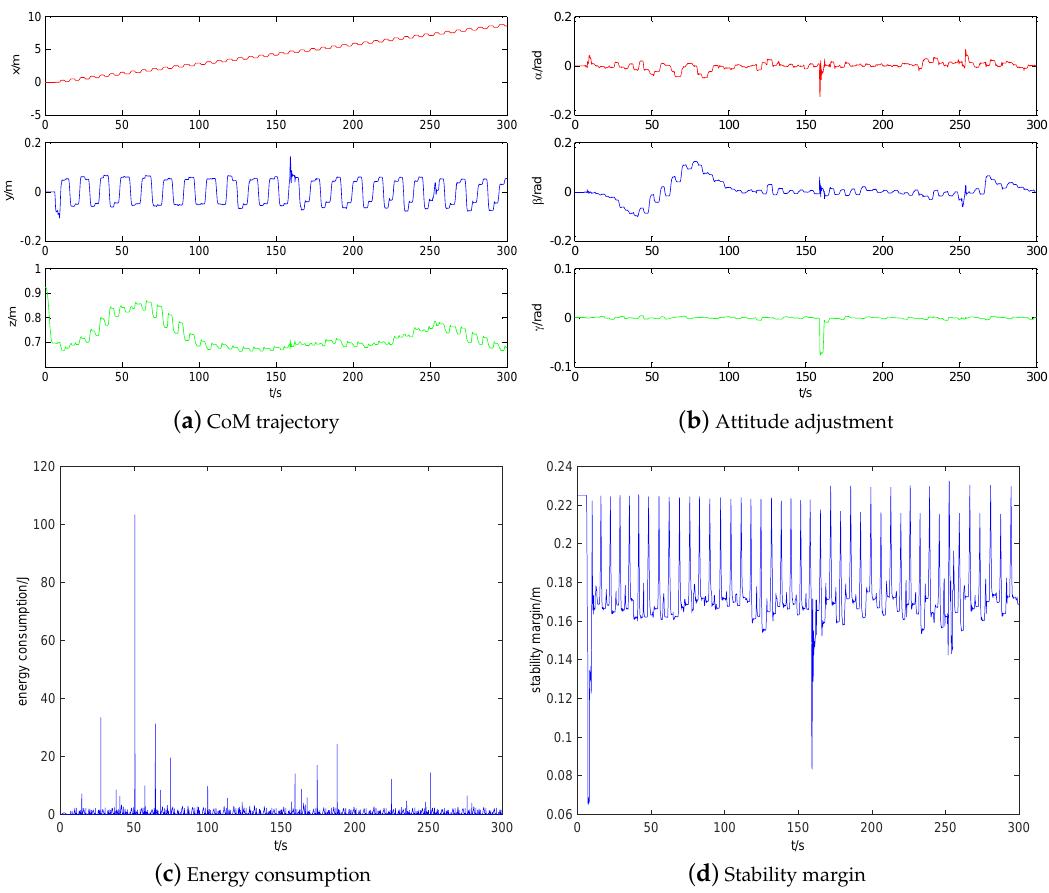
Figure 19. Simulation results of quadruped robot walking on uneven